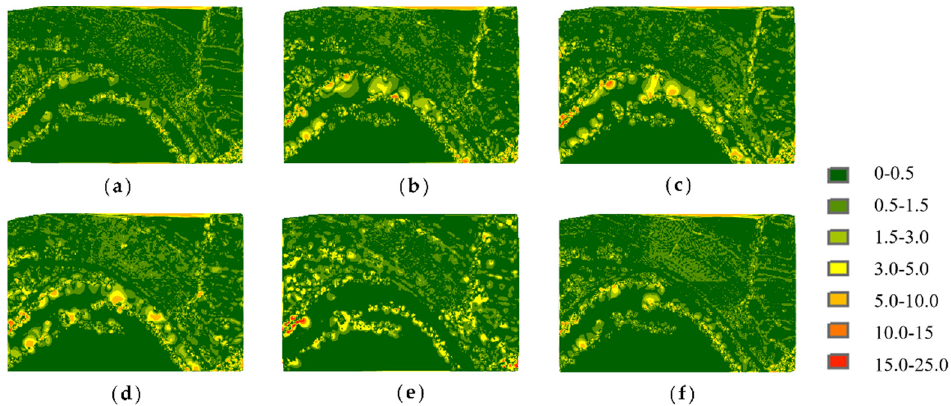
Figure 10. Elevation difference distributions of Samp52: ( a ) MIWSA; ( b ) random algorithm; ( c ) nor- mal algorithm; ( d ) voxel algorithm; ( e ) k-means algorithm; ( f ) curvature algorithm.